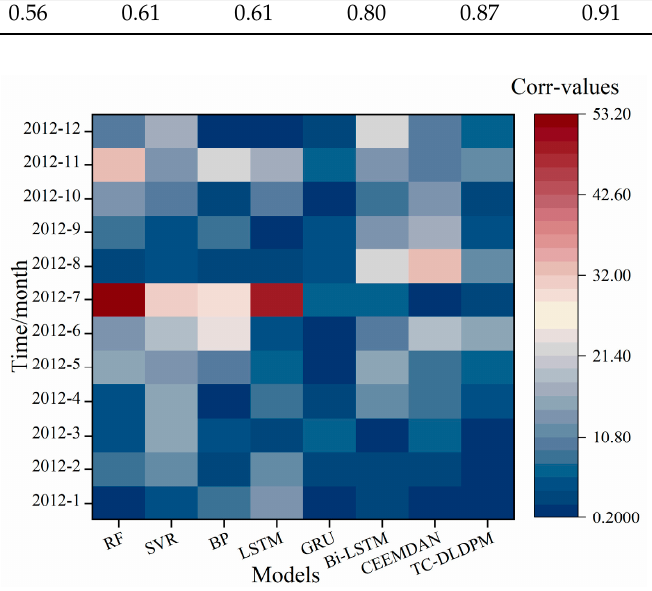
0.95 By comparing the simple deep learning model Bi-LSTM and the combined deep learning model CEEMDAN which have better prediction precision than the TC-DLDPM model proposed in this paper on the ZG110 testing set, the prediction fitting results can be seen in Figure 20. Among the three prediction methods, the fitting result of Bi-LSTM is the worst. Combined with the error analysis in Table 3, the MAE error of the Bi-LSTM is